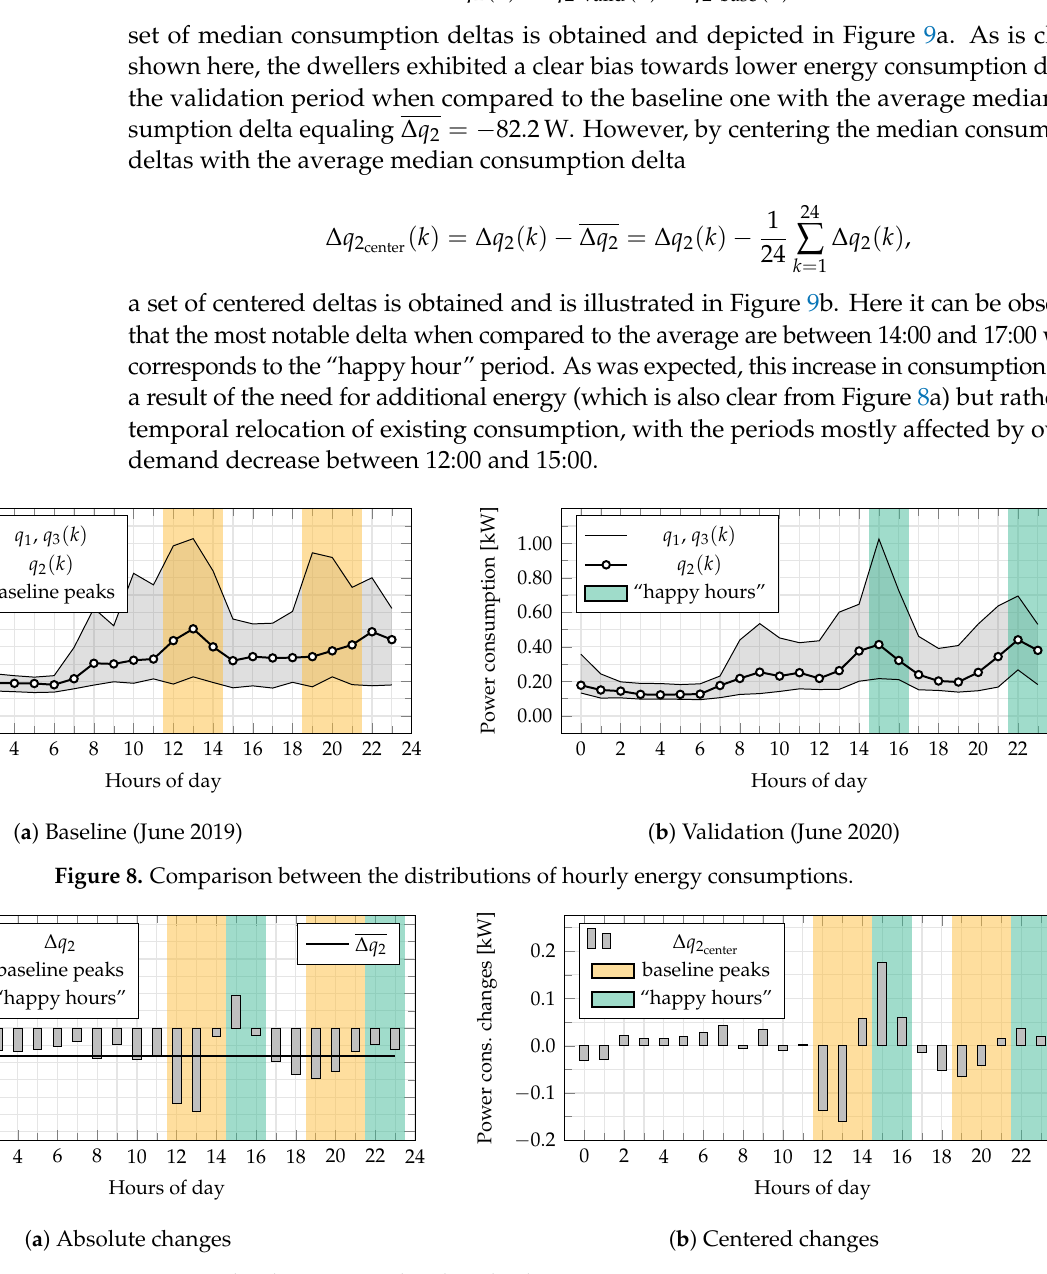
Figure 9. Deltas between median hourly electric energy